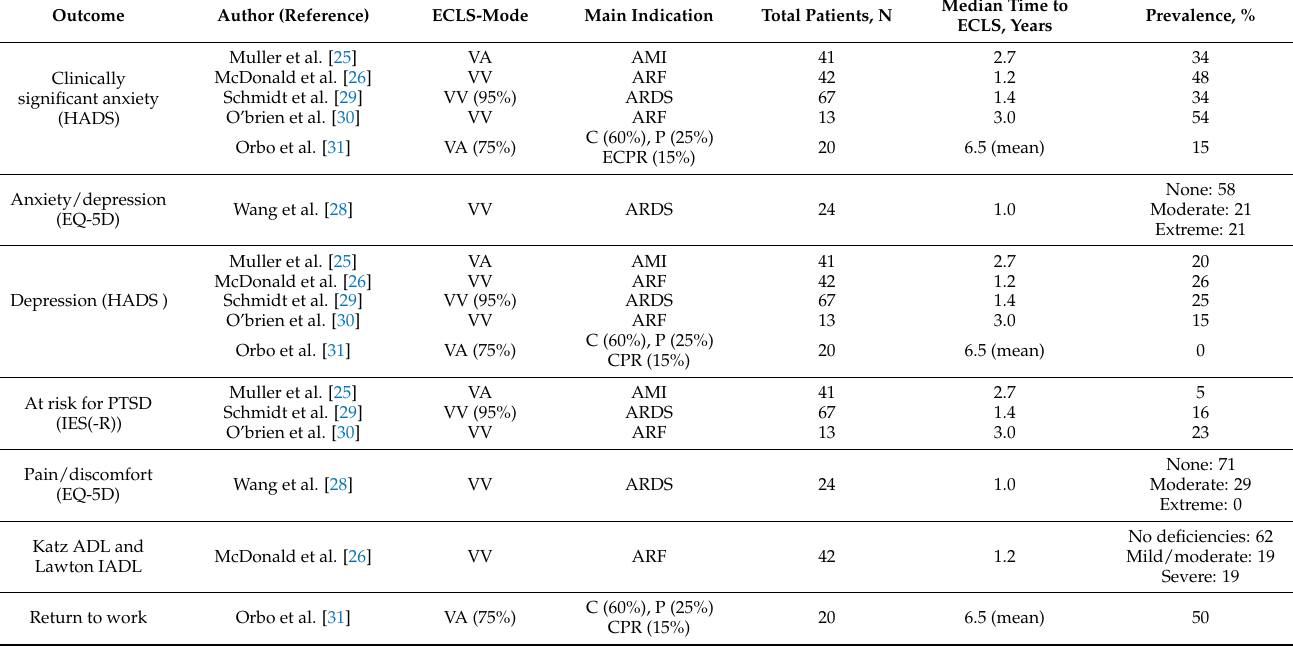
Table 1. Overview of psychological and functional outcomes after